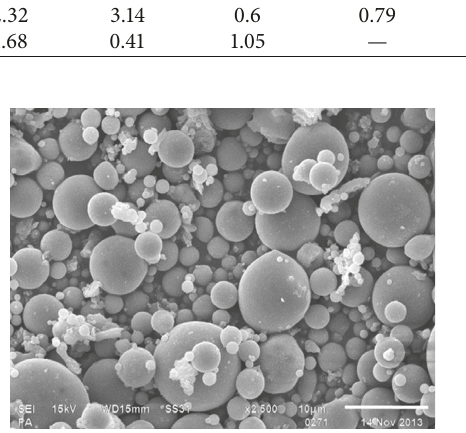
Figure 1: Micromorphology of grade I fly ash.